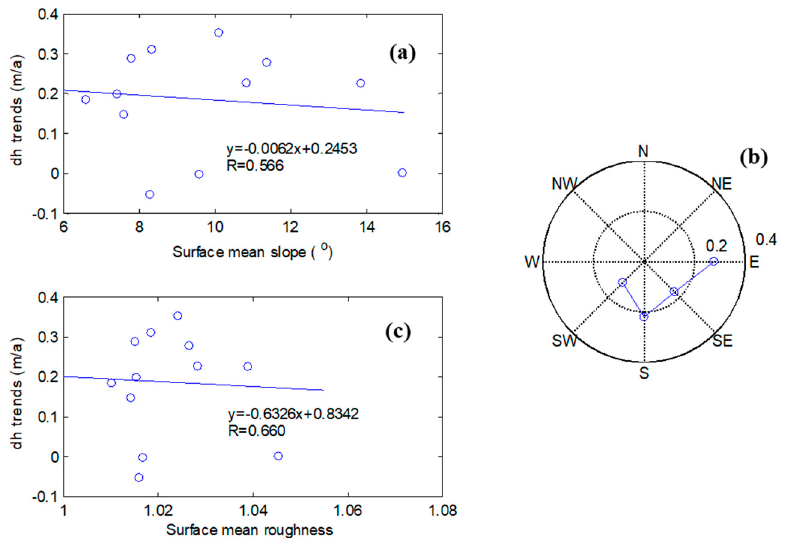
Figure 9. Trends of individual glaciers versus mean ( a ) slope, ( b ) aspect, and ( c ) roughness. Blue dots in ( a ) and ( c ) represent 12 glaciers listed in Table 1, and the corresponding blue lines represent their linear fitting. Blue dots in ( b ) represent the 4 large slope glaciers’ (ID.7,8,9,10 in Table 1) standard deviation of dh trends.